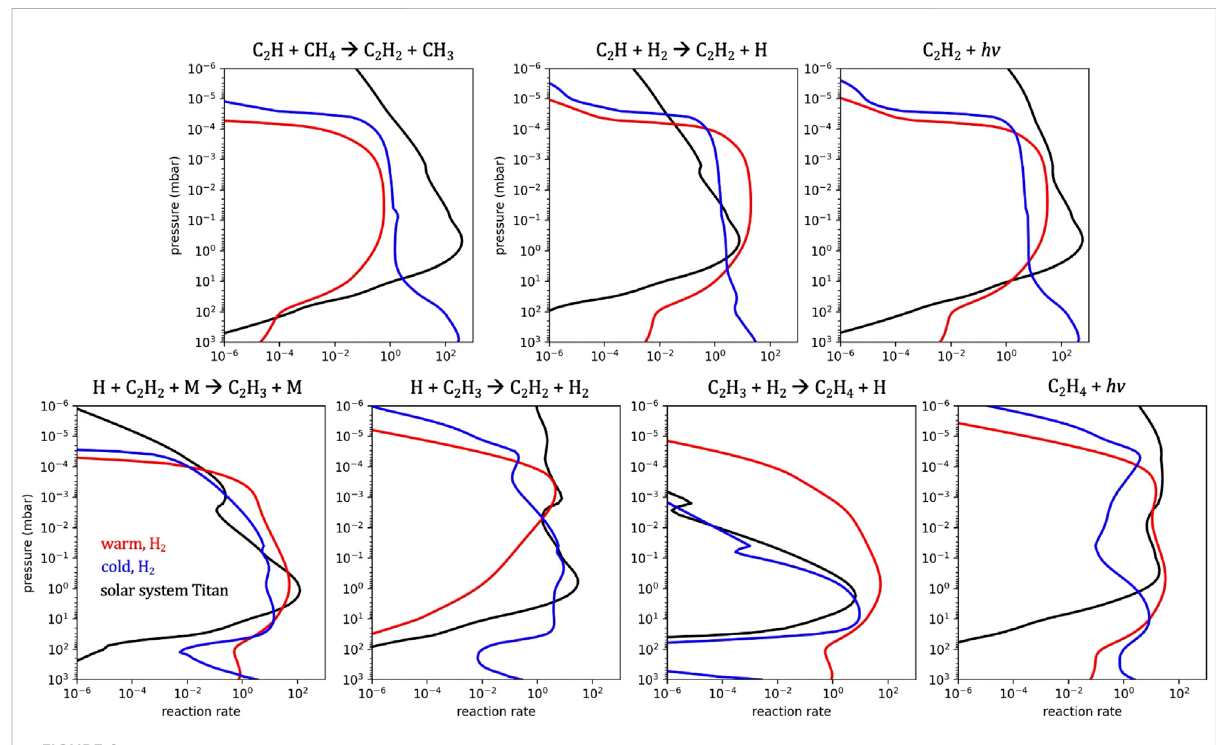
FIGURE 9 Rates(cm − 3 · s − 1 )ofdominantproductionandlossreactionsforC 2 H 2 inthetoppanel.RatesofexchangereactionsbetweenC 2 H 2 -C 2 H 3 -C 2 H 4 in the bottom panel. Black lines represent a cold N 2 atmosphere (Titan), blue lines represent a cold H 2 atmosphere, and red lines represent a warm H 2